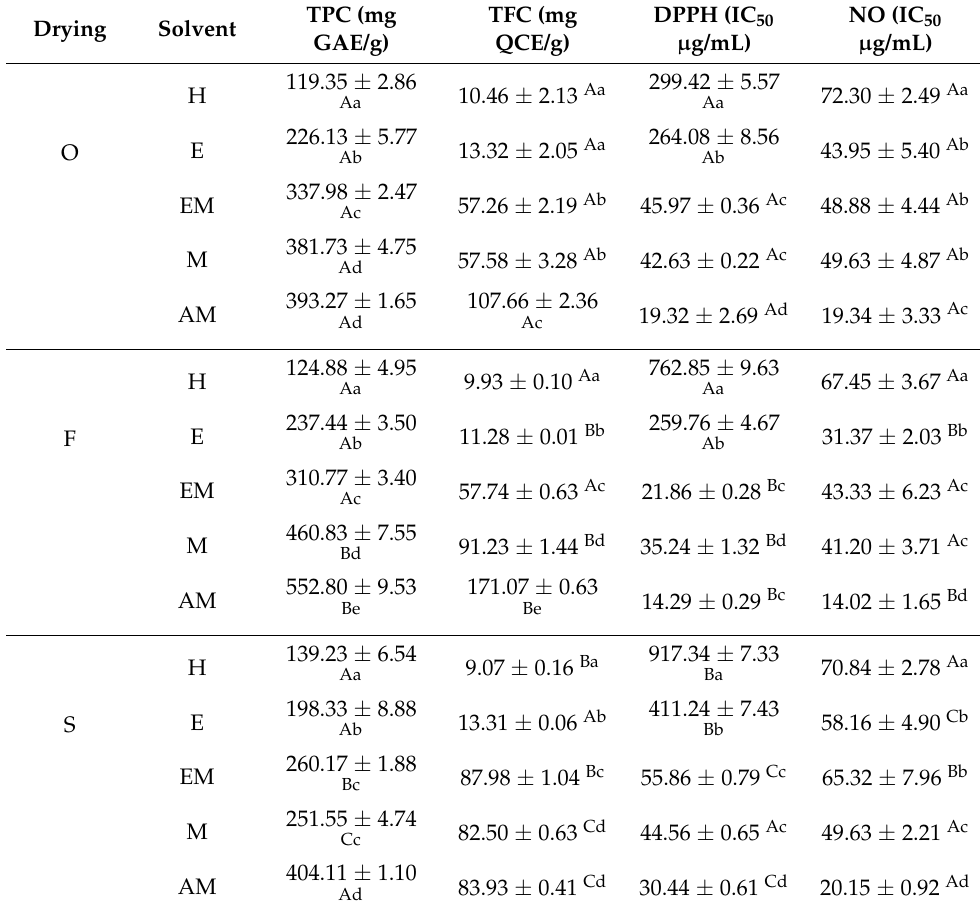
Table 5. Influence of drying methods and solvent systems on polyphenolic content and antioxidant activity of